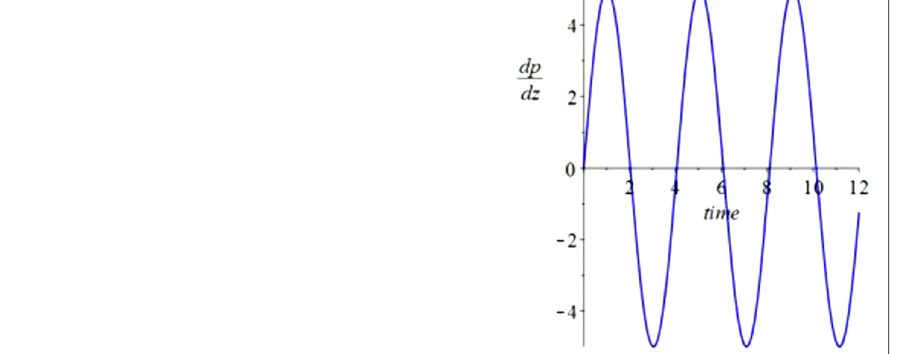
Figure 1 Oscillating pressure